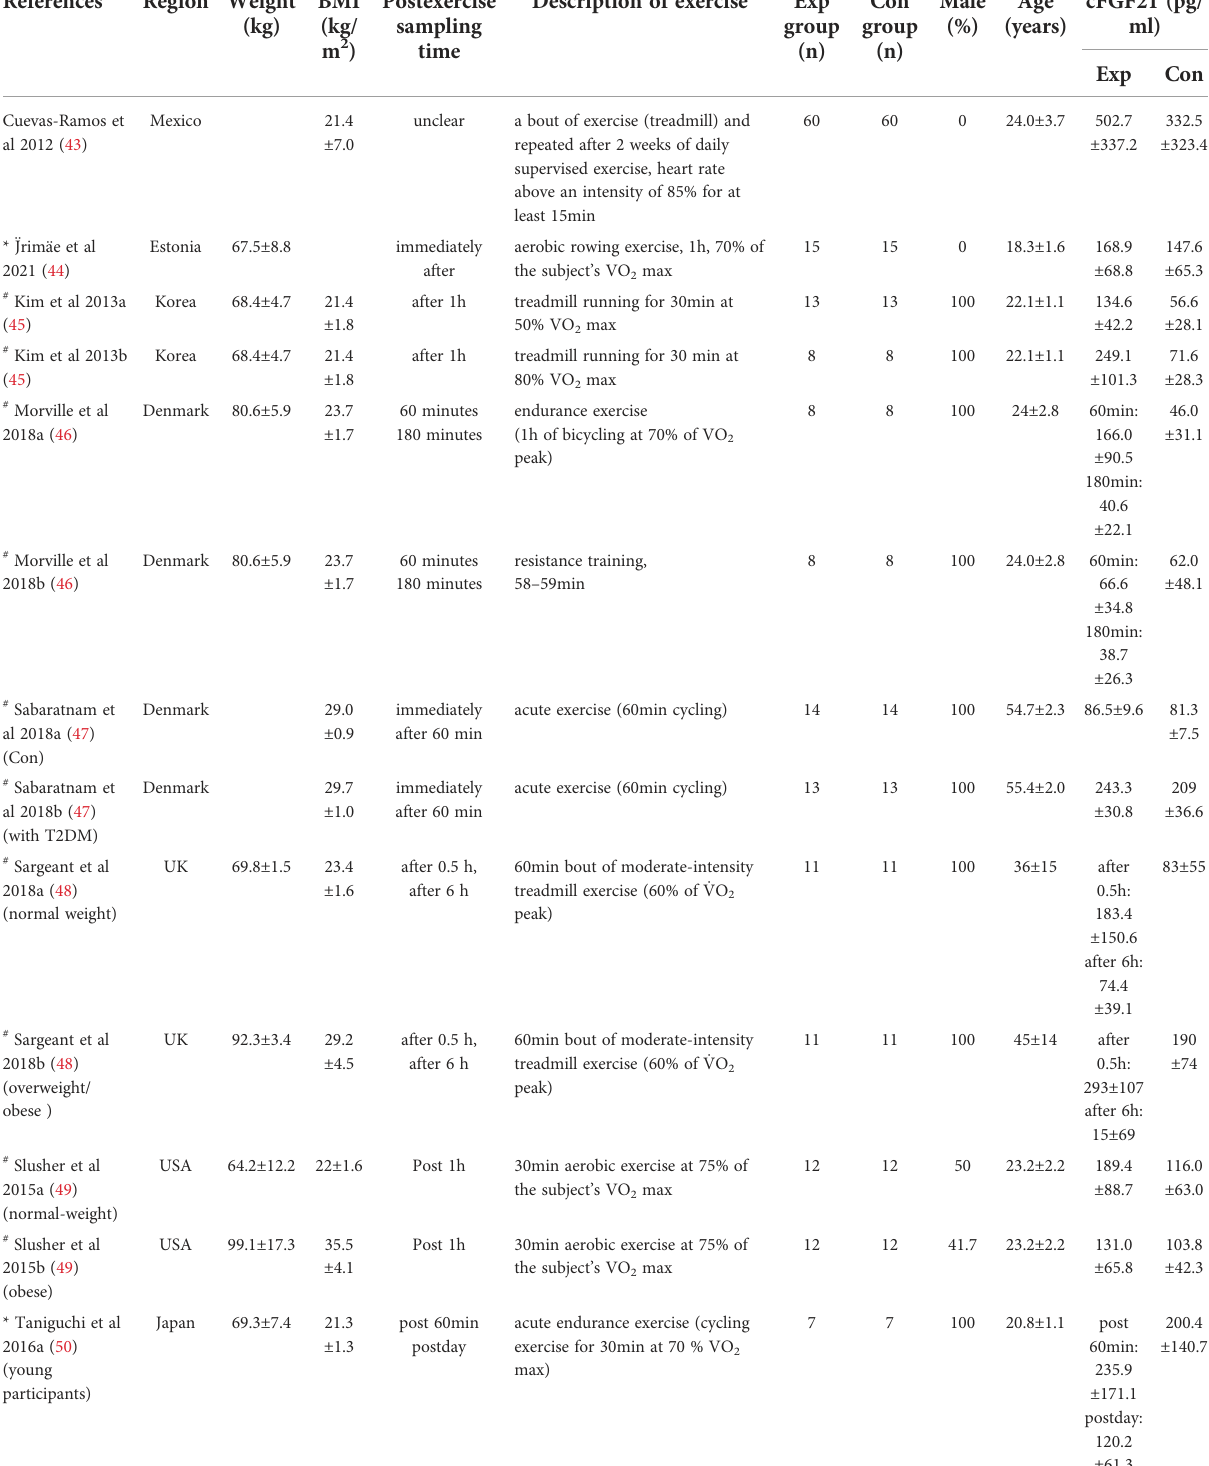
TABLE 5 Baseline characteristics of studies reported cFGF21 concentration in subjects with or without physical activity